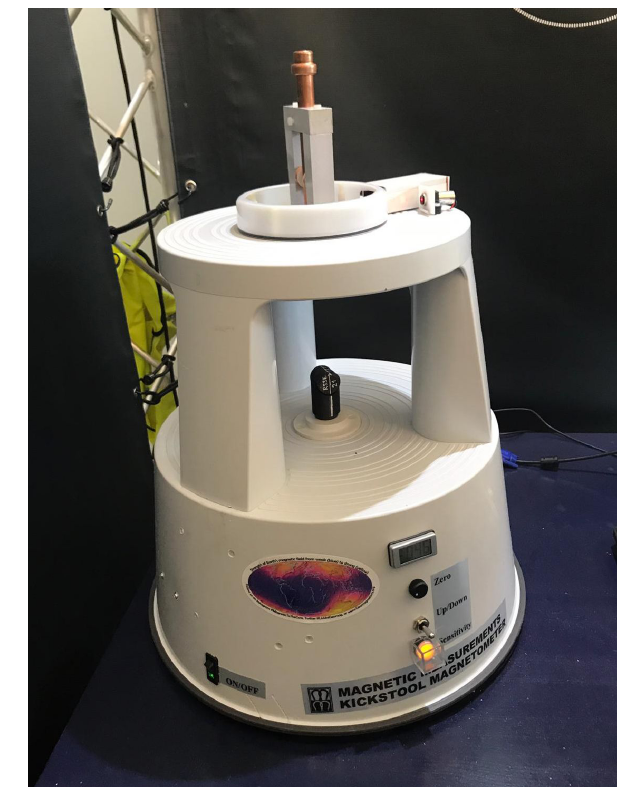
Figure 2. The kickstool